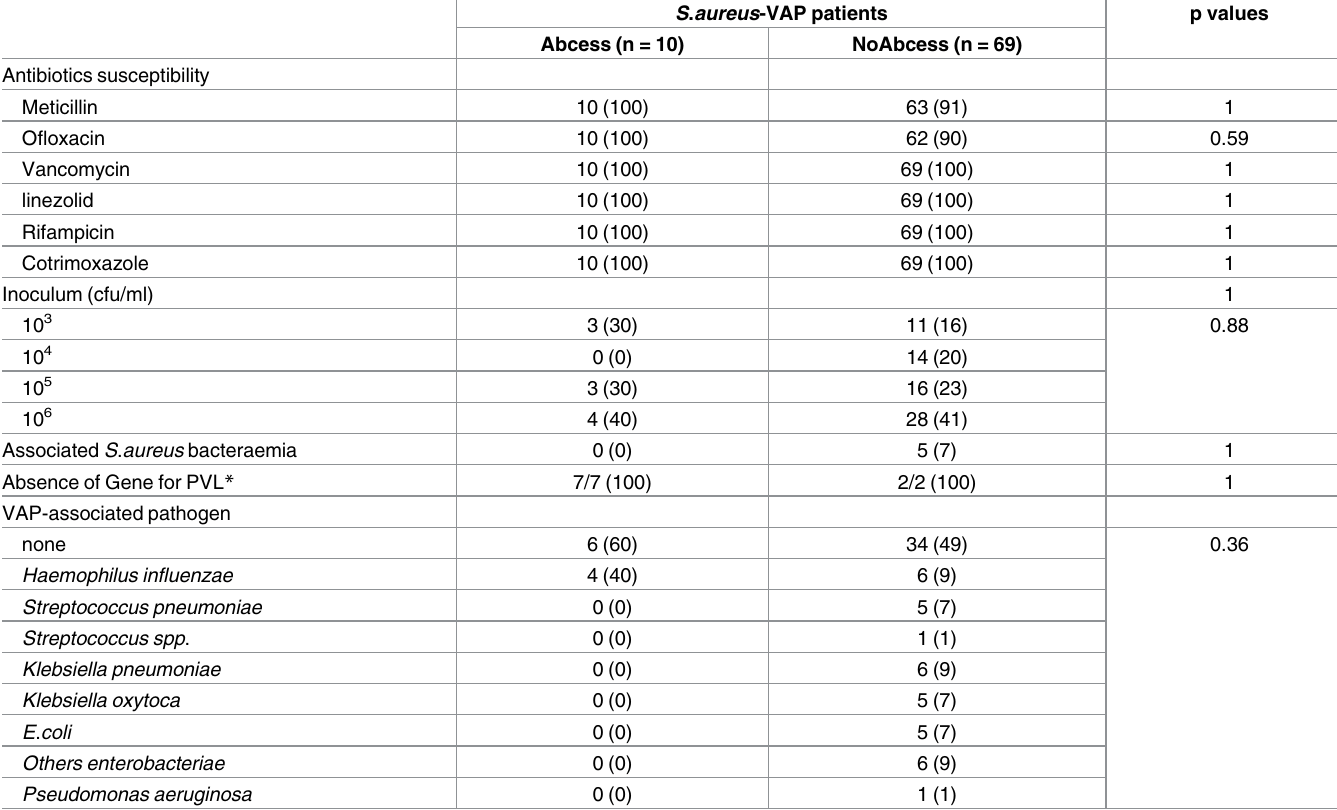
Table 3. Details of S . aureus -VAP risk factors for LA